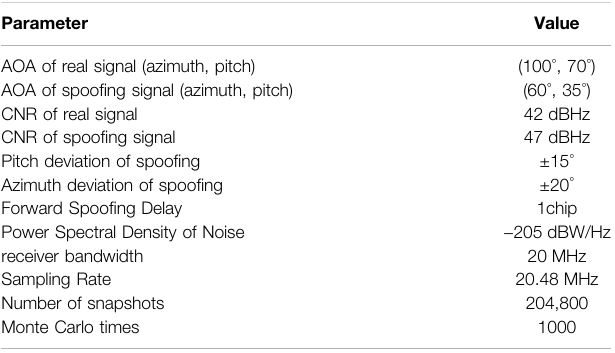
TABLE 2 | Parameter setting of real and spoo fi ng signals.